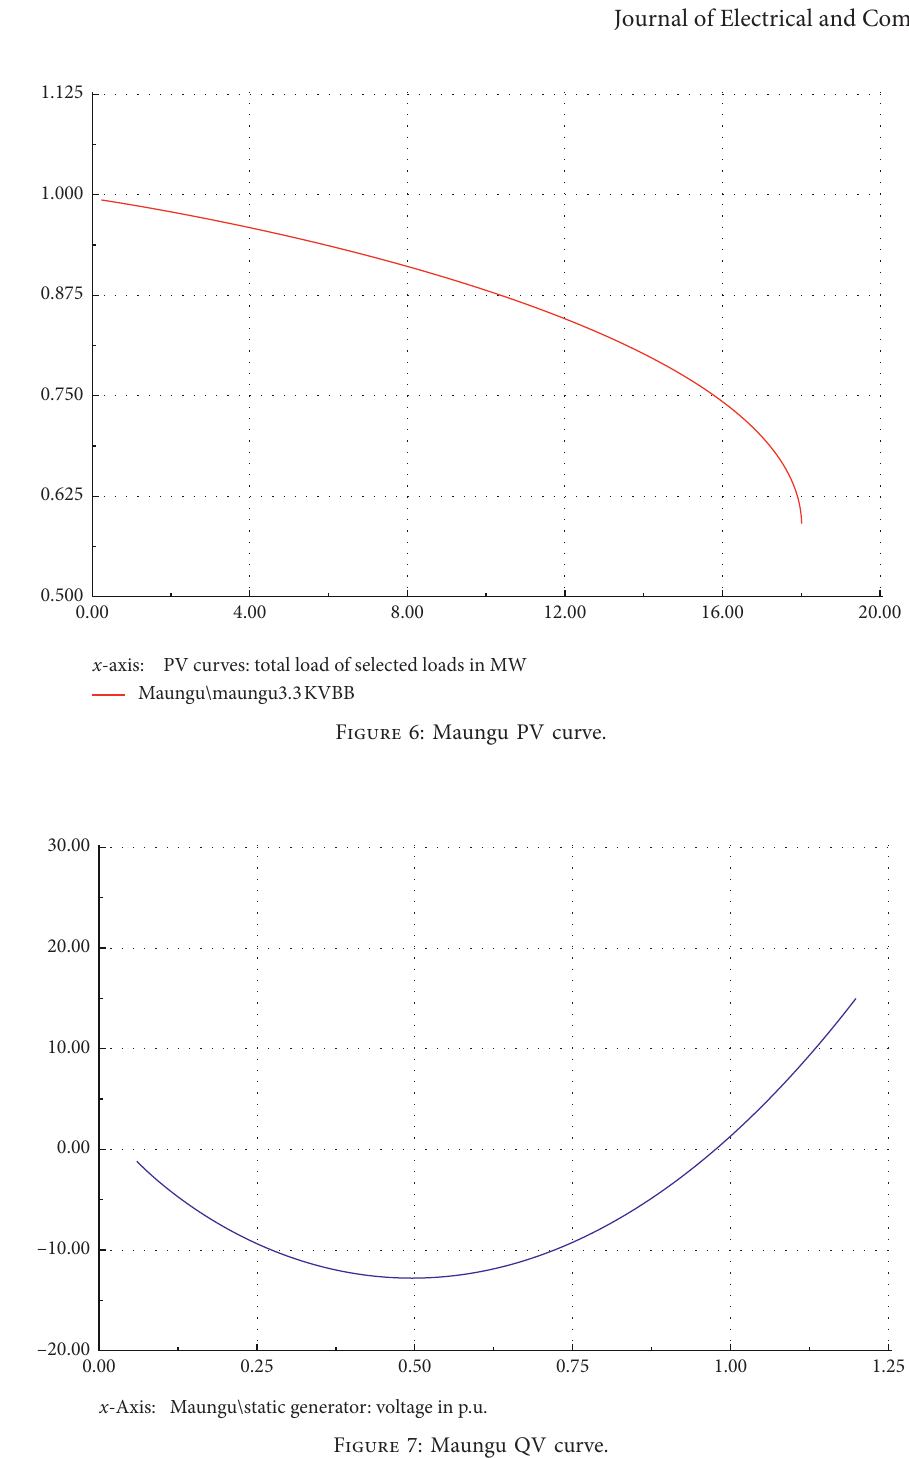
Figure 7: Maungu QV